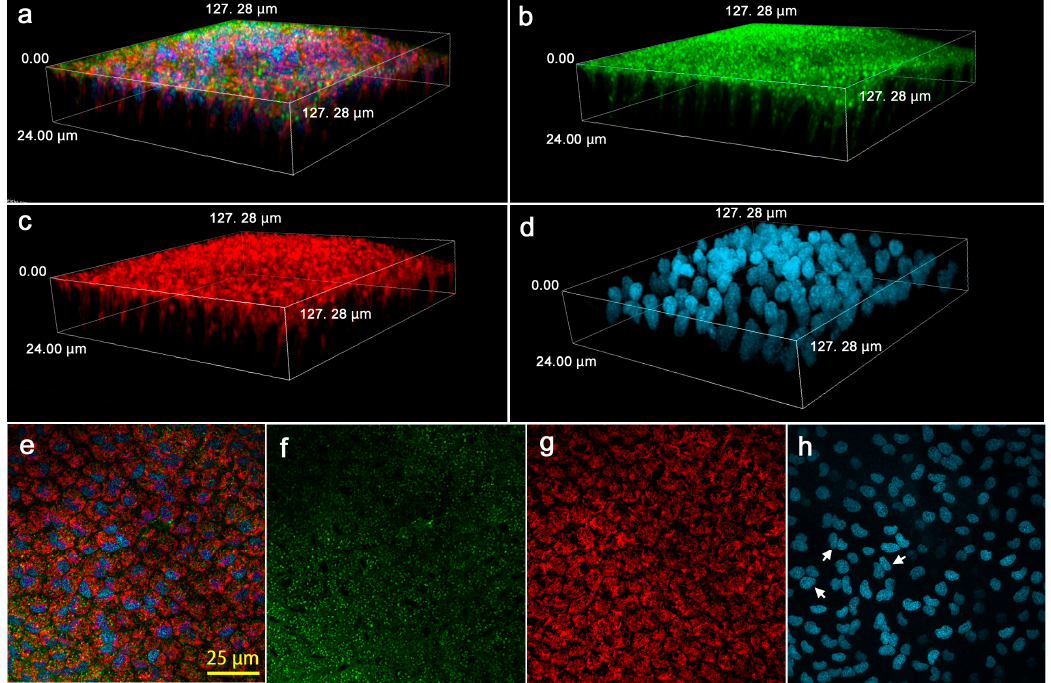
Figure 14. Cellular structures and organelles near the discal spot in the ventral forewing. ( a ) 3D image reconstitution of the ventral epithelium stained with three fluorescent dyes; Golgi apparatus and membrane (green), mitochondria (red) and nuclei (cyan). ( b ) 3D image of staining for the Golgi apparatus and membranous structure. ( c ) 3D image of staining for mitochondria. ( d ) 3D image of staining for nuclei. ( e ) 2D image of the ventral epithelium stained with the three fluorescent dyes. ( f ) 2D image of staining for the Golgi apparatus and membranous structure. In addition to the Golgi apparatus (numerous green dots), the plasma membranes are stained, indicating that epithelial cells are tightly packed. ( g ) 2D image of staining for mitochondria. ( h ) 2D image of staining for nuclei. Doublets and triplets are frequently observed (arrows).